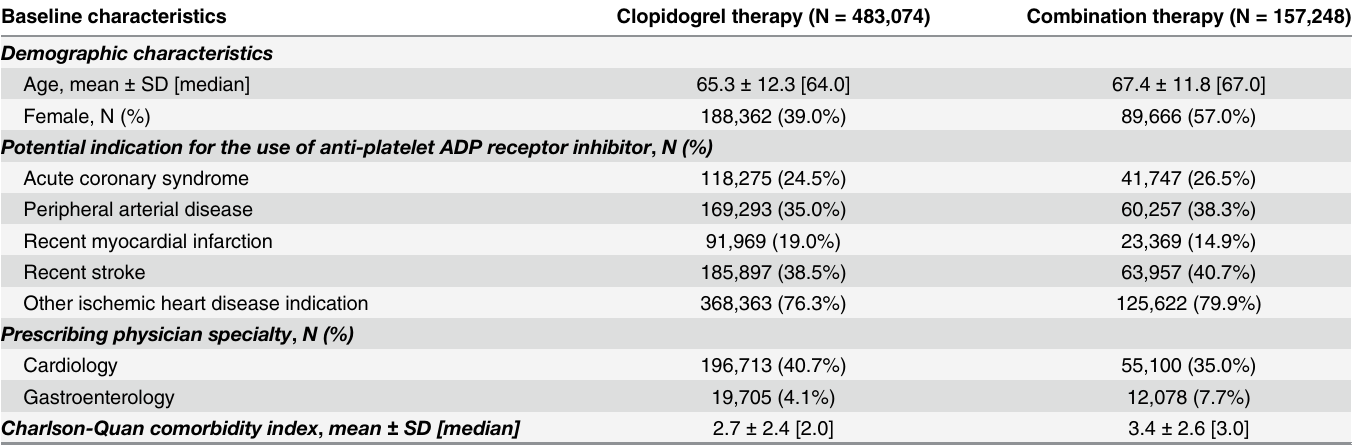
Table 1. Characteristics of patients initiated on clopidogrel therapy and clopidogrel-PPI combination